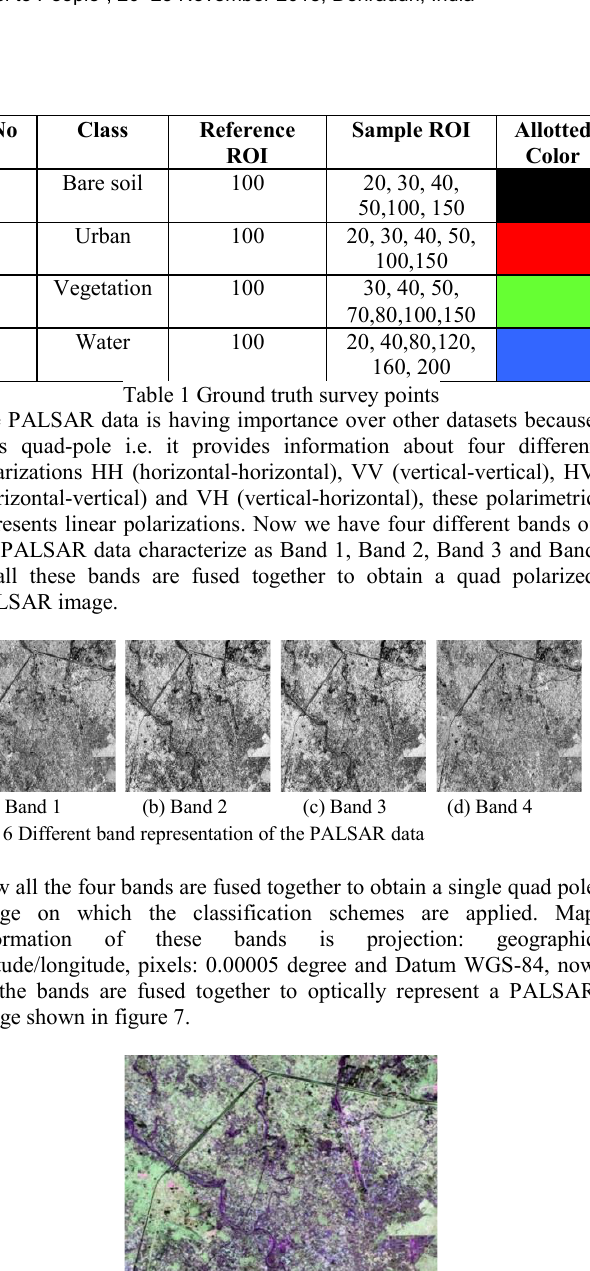
Fig.7 Band fused PALSAR image (Band 1+Band 2+ Bands 3+Band